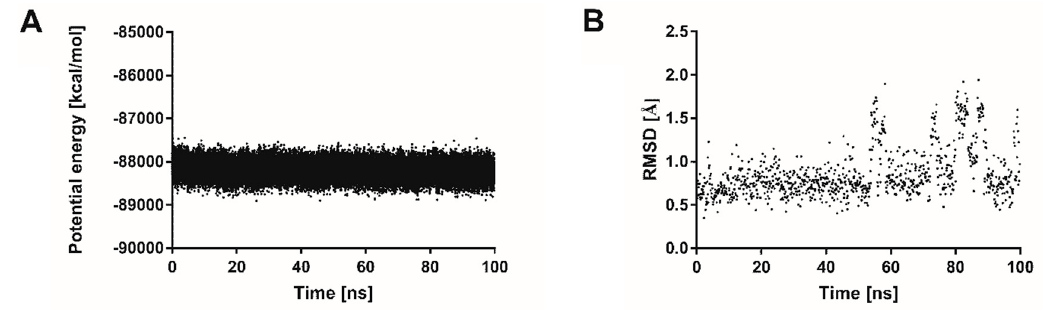
Figure 6. Changes in potential energy ( A ) and ligand RMSD ( B ) during 100 ns molecular dynamics simulations for D2AAK1_3 in complex with human dopamine D 2 receptor.